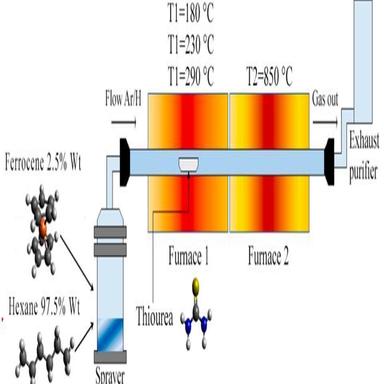
Cristina L. Rodríguez-Corvera et al. Schematic representation of the chemical vapor deposition (CVD) method considering two furnaces. T1 and T2 refer to the temperatures of furnace-1 and furnace-2, respectively. In furnace-1, the thiourea powder is placed in an alumina container. A mixture of N-hexane and ferrocene is transported through a quartz tube under an Ar/H gas flow. All experiments were performed with T2 = 850 ◦C, and three values of T1 were considered (180, 230, and 290 ◦C). The thermal decomposit